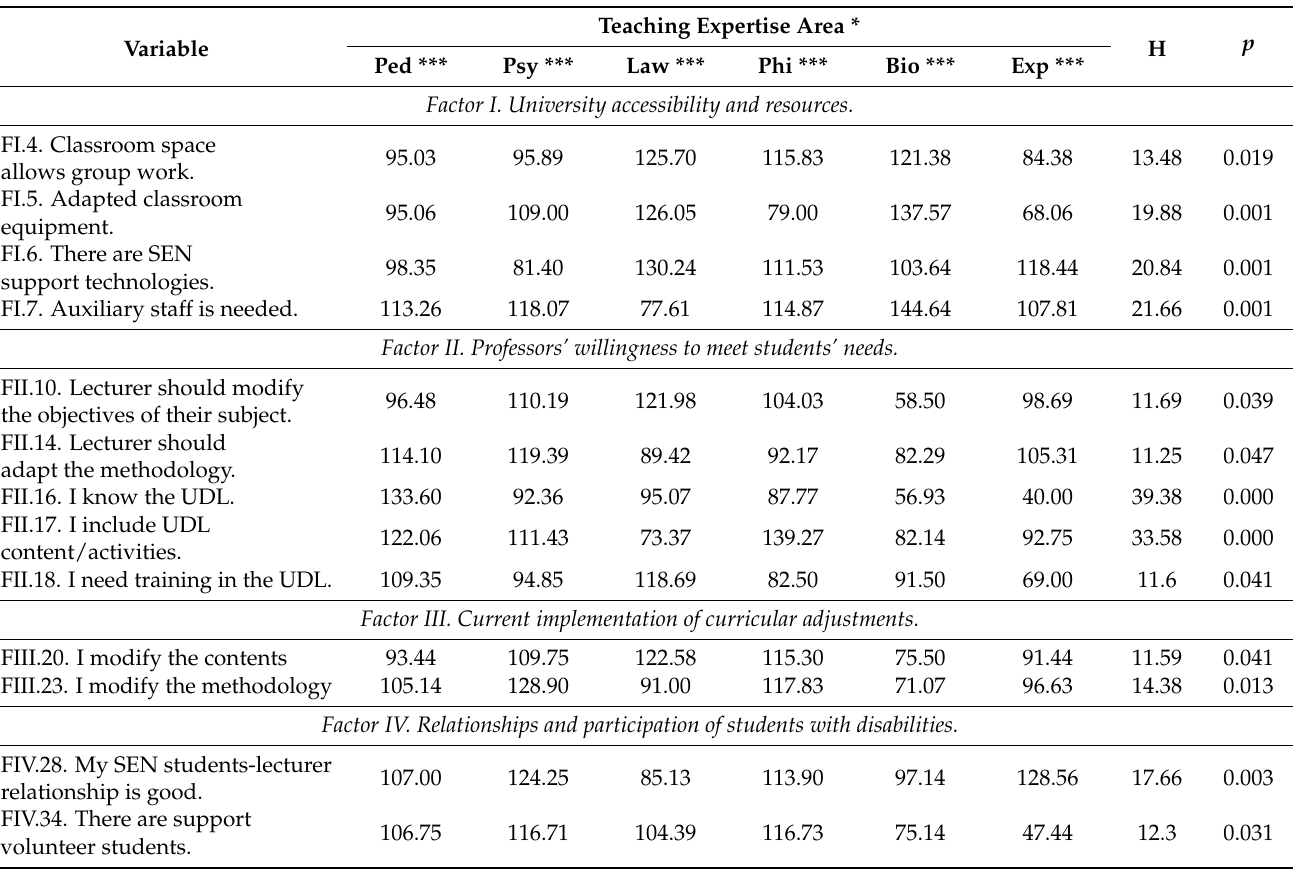
Table 12. Kruskal–Wallis analysis according to the teaching